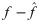
The decomposition process of the original image f into the artifacts image va, the fibers image uf and noise f-f^.(a) Image f. (b) Artifacts image va. (c) Fibers image uf. (d) Reminder noise f-f^. Solution obtained after 100 iterations with δ = 3.